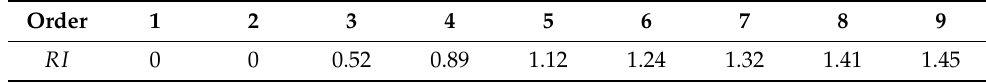
Table 3. Average random consistency